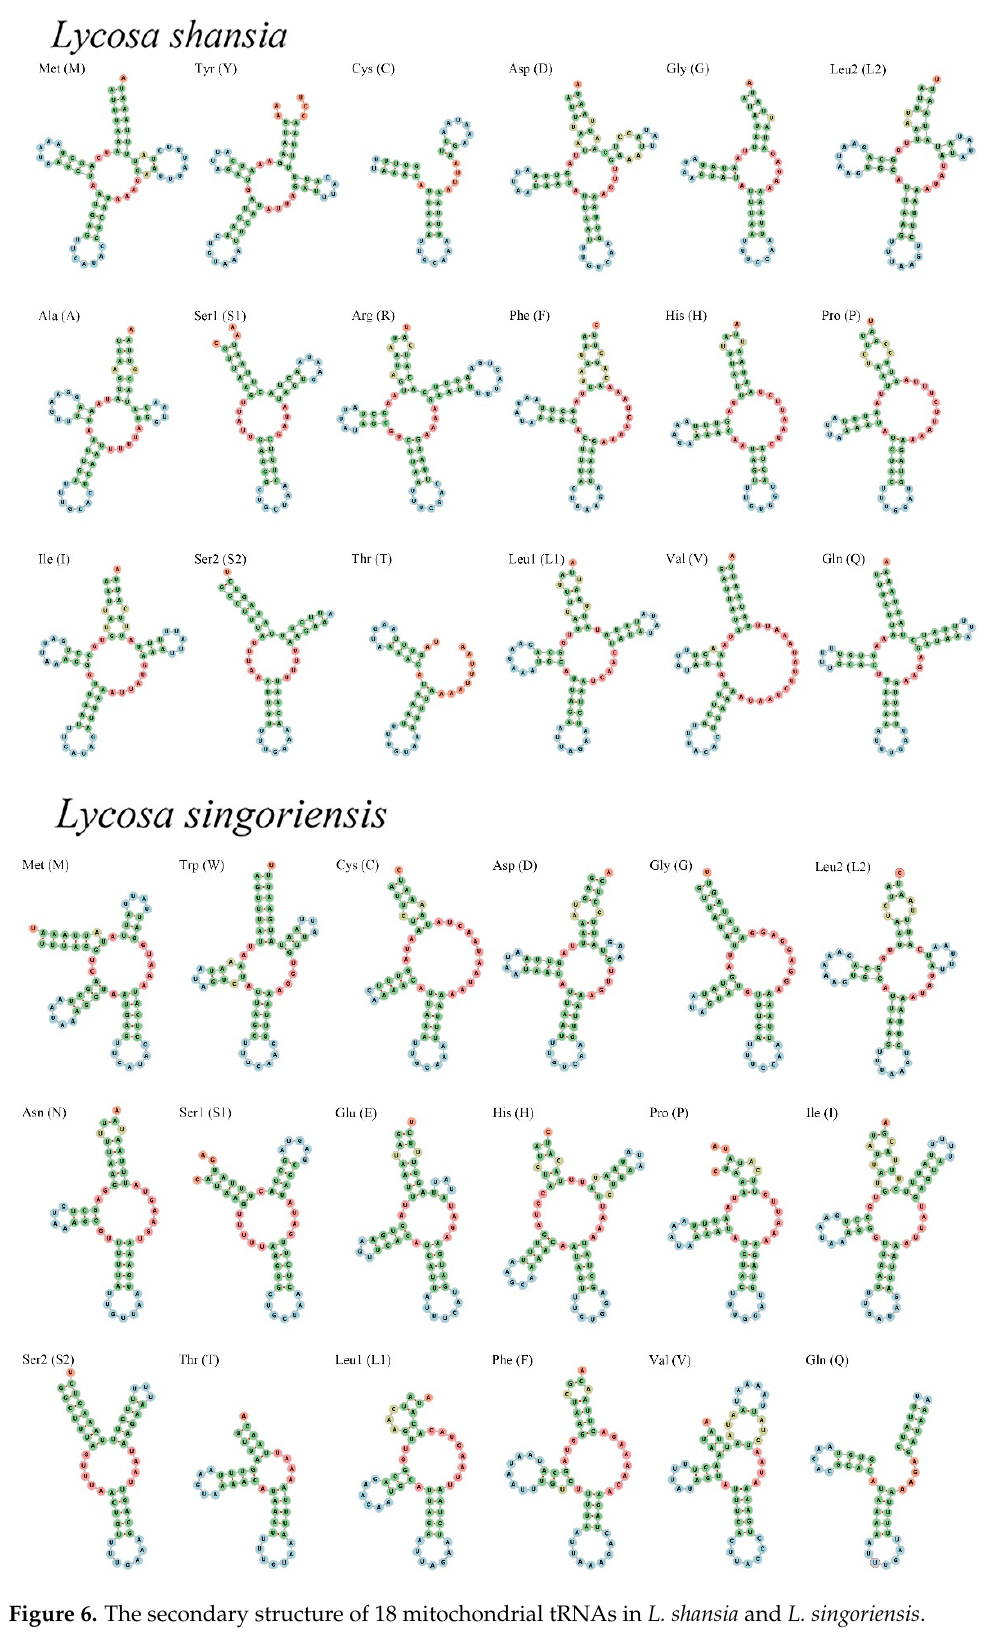
Figure 6. The secondary structure of 18 mitochondrial tRNAs in L. shansia and L. singoriensis.